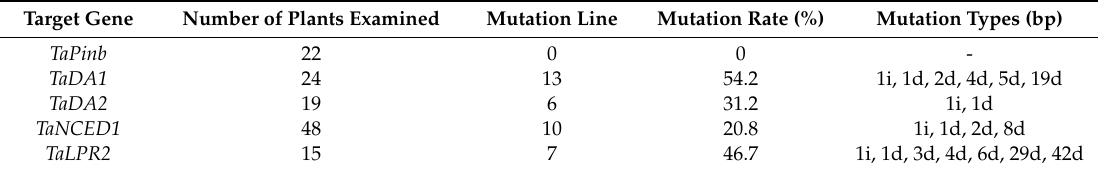
Table 1. Targeted mutagenesis in T0